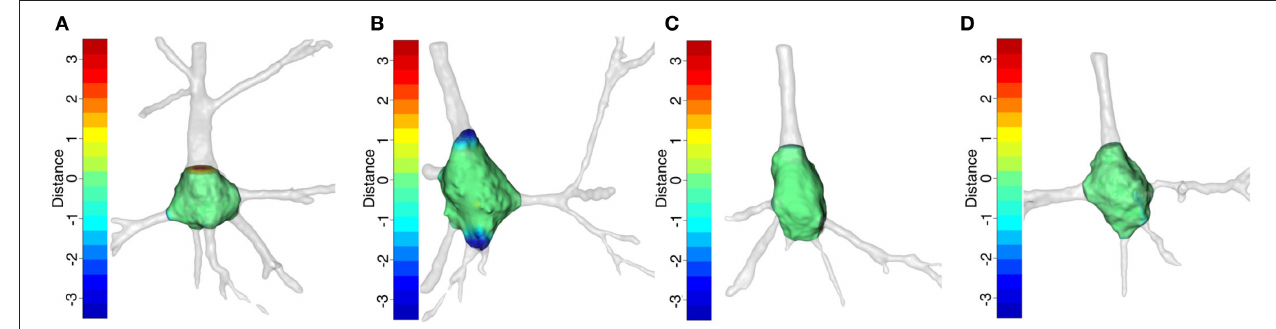
FIGURE 11 | Somata with their primary dendrites after manual segmentation. The somata surface is green. The cutoffs are denoted by a color on a scale between red and blue in such a way that the longest distances are denoted by the end colors and the shortest distances by an equal combination of both. The opacity of the primary dendrites was decreased in order to show up the colors of the cutoffs. (A,B) illustrate the somata with the greatest differences according to Figure 10 , i.e., (A) is Neuron 5 segmented by the first neuroanatomist and (B) is Neuron 4 segmented by the second neuroanatomist. (C,D) show the somata with the smallest differences, i.e., (C) is Neuron 2 segmented by the first neuroanatomist (D) is Neuron 3 segmented by the second neuroanatomist.